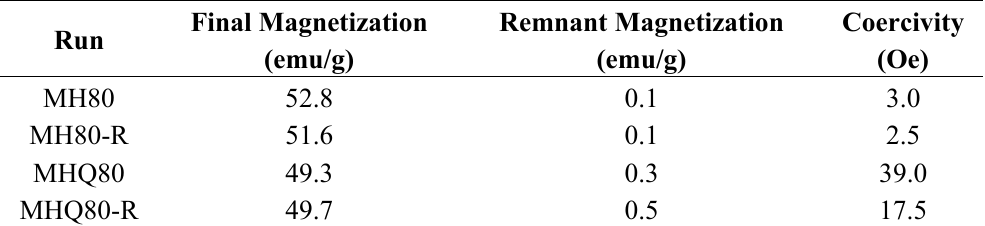
Table 1. Results from magnetic measurementsof nanoparticles.